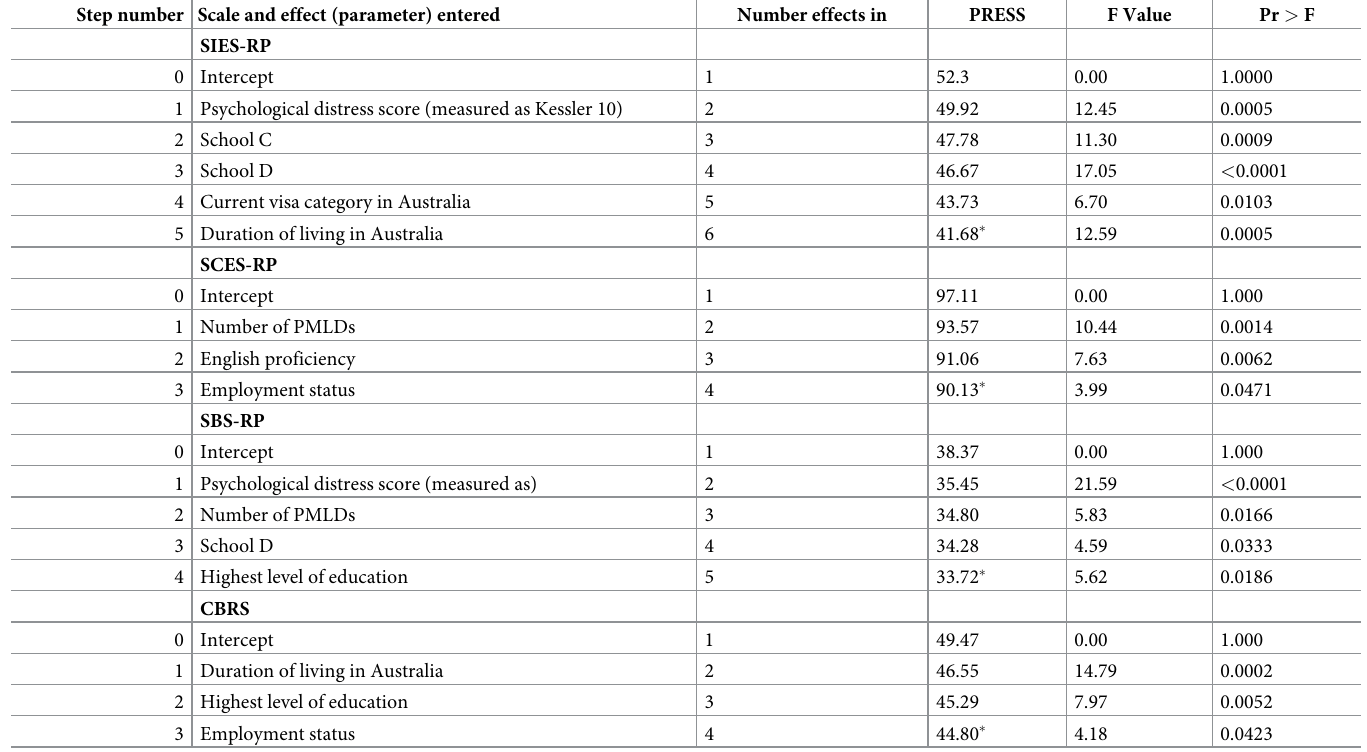
Table 7. LASSO regression calculation: Forward selection summary for each of the outcome variable. Step number Scale and effect (parameter)